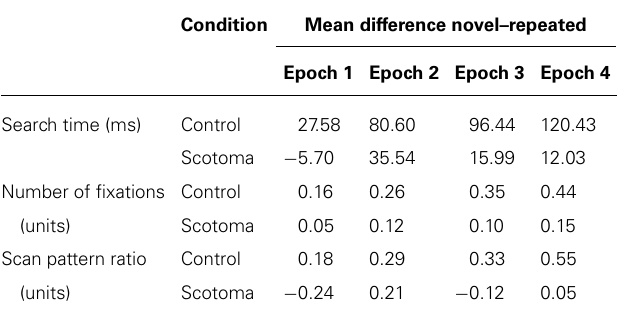
Table 1 | Mean difference between novel and repeated configurations.